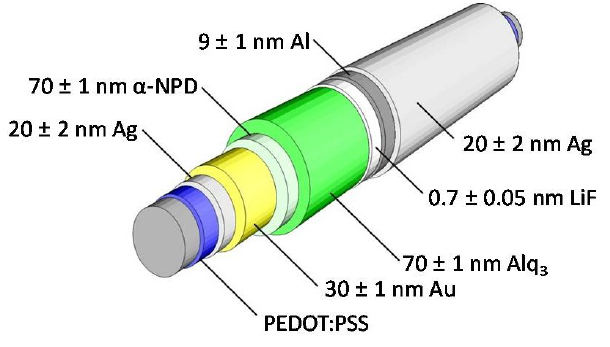
Figure 8. Illustration of the fiber OLED layer sequence. All materials were deposited by subsequent resistive evaporation in a vacuum